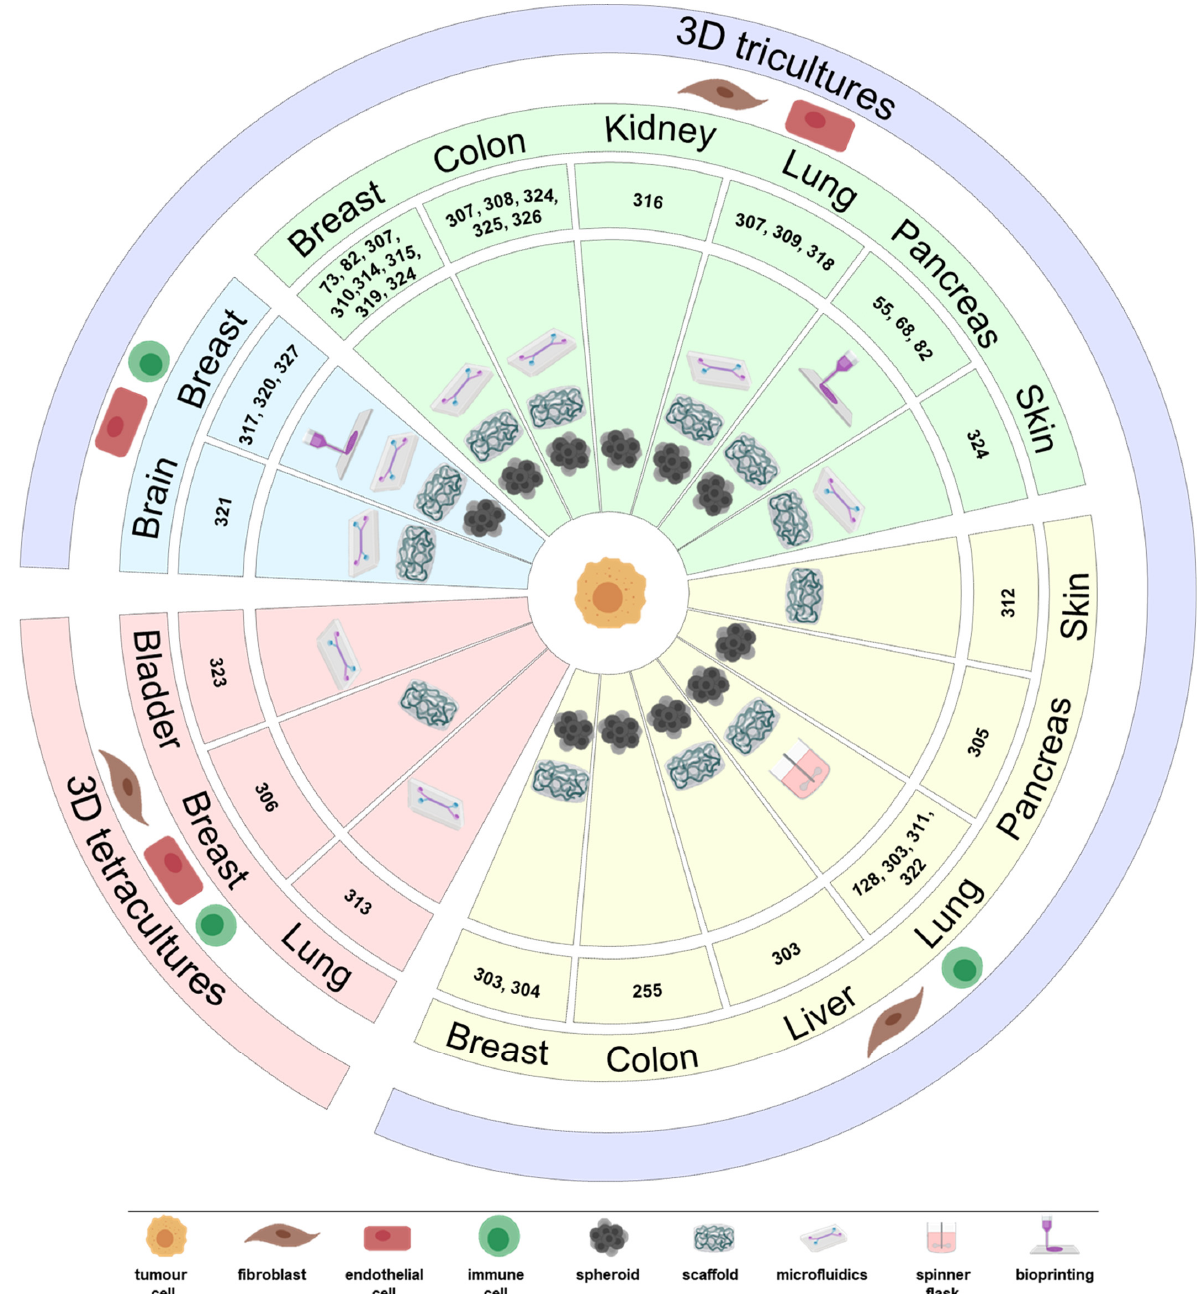
Figure 3. Schematic diagram showing examples of co-cultures of tumour cells with two or more tumour microenvironment cell components (fibroblasts, endothelial or immune cells) using different 3D approaches heterotypic spheroids and scaffold- based methods (artificial or animal-derived), employing distinct culture systems, such as spinner-flasks and microfluidic devices, and innovative techniques for generation of the 3D cultures, such as bioprinting [55,68,73,82,128,195,303–327]. Created with Biorender